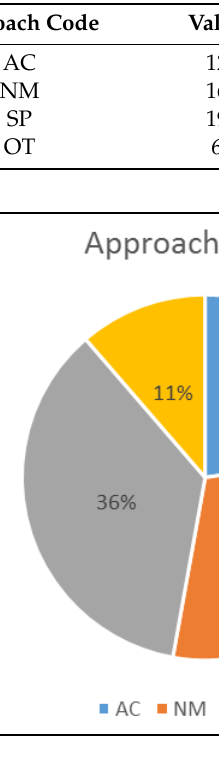
Figure 2. Approach coding.